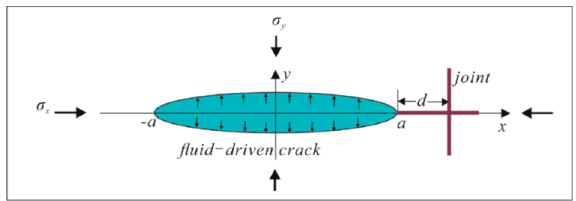
Figure 7. Model diagram of fractures with fluid pressure.